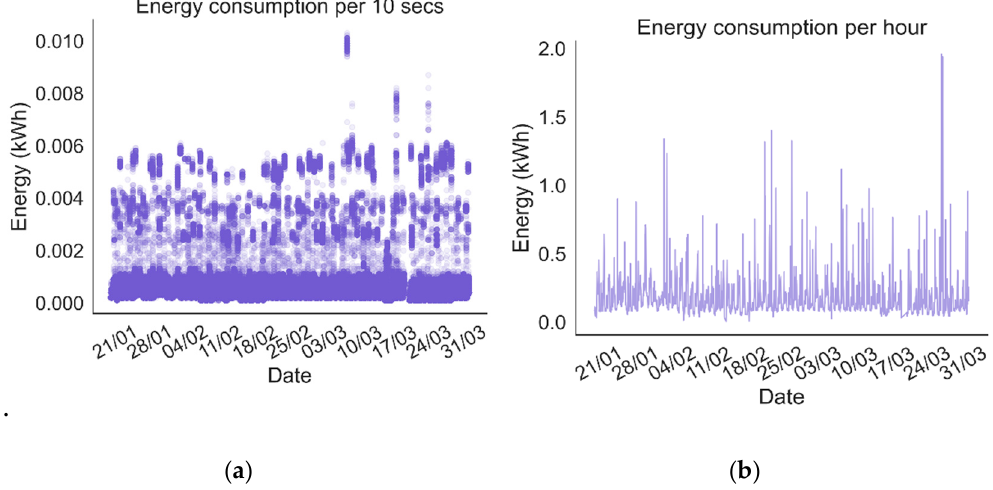
Figure 9. ( a ) Energy consumption per 10 s; ( b ) Average energy consumption per hour.